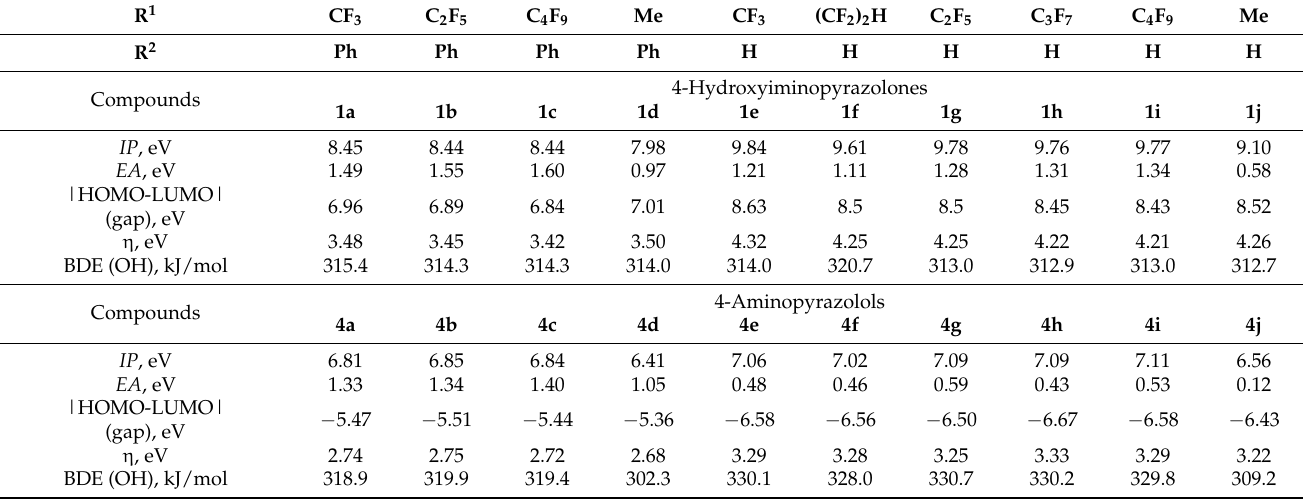
Table 3. Vertical values (IP, EA, η ) and BDE(OH) of compounds 1a – j , 4a – j